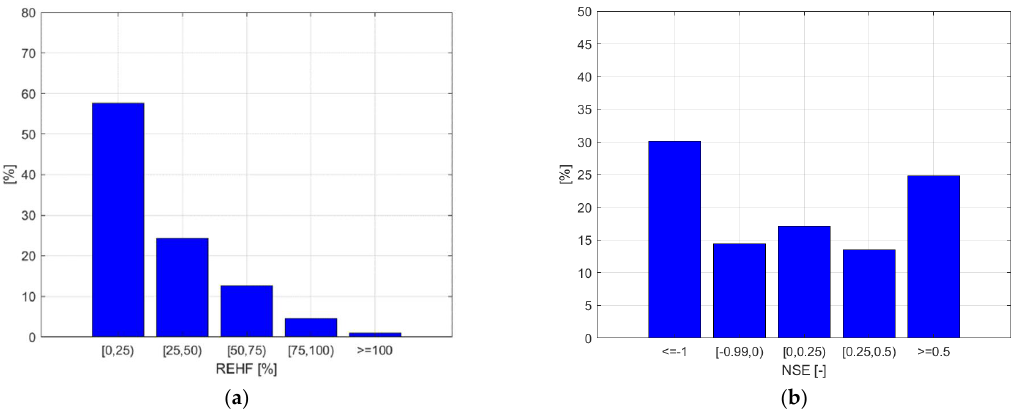
Figure 13. Frequency histograms of REHF ( a ) and Nash–Sutcliffe ( b ), considering all the study sections.